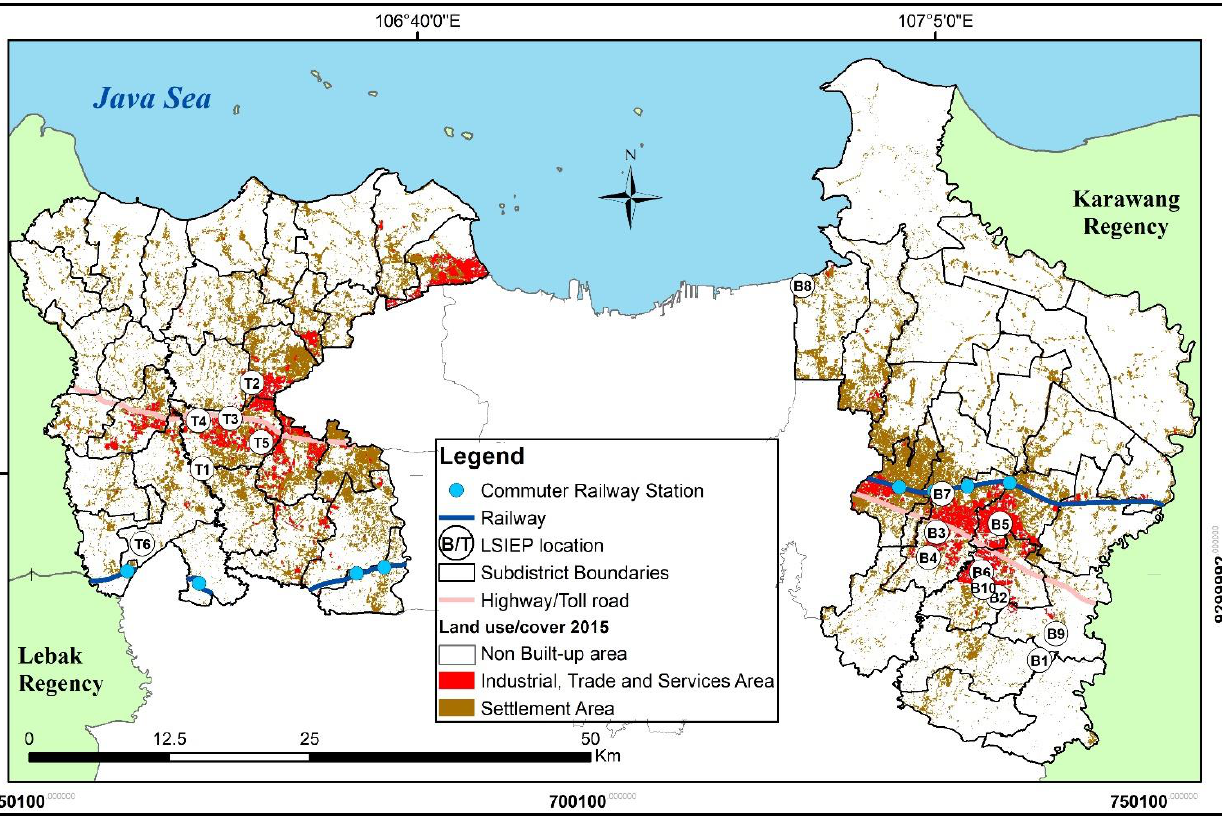
Figure 6. The distribution of LSIEP and the built-up area in 2015.